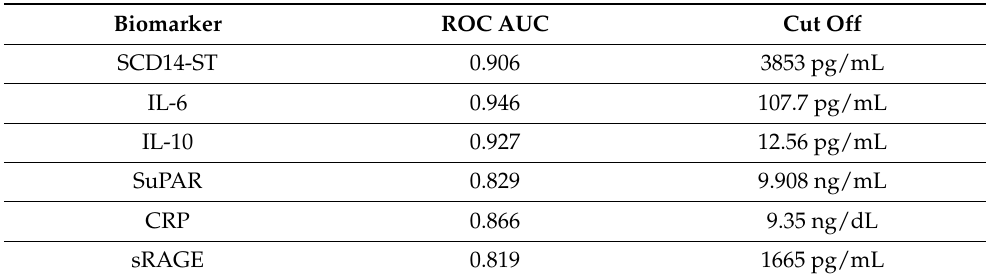
Table 2. AUC (area under the curve) of ROC (receiving operating curve) and cut-off of SCD14-ST and the other inflammatory markers evaluated. Correlation (Spearman r, 95% confidence interval) of SCD14-ST with the other inflammatory biomarkers and the severity scores analyzed in the study.